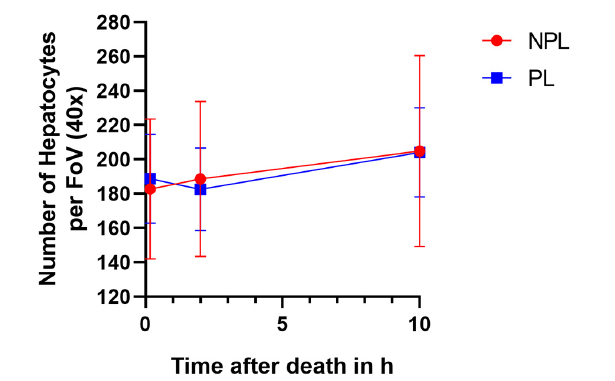
FIGURE 5 | Mean with SD of numbers of hepatocytes per field of view (FoV) counted at 40x optical field at three time points (fresh, 2 h post-mortem, and 10 h post-mortem) for both NPLs ( n = 7) and PLs ( n = 7). For each animal, two images were analyzed. NPL: non-perfused liver; PL: perfused